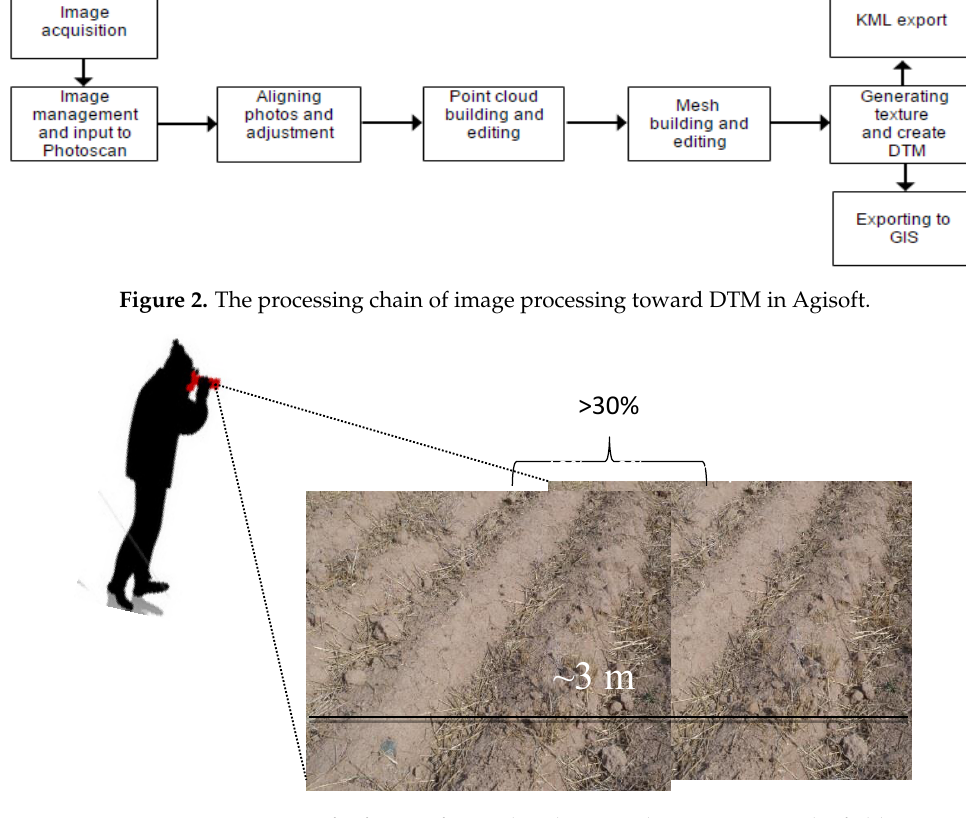
Figure 3. Acquisition of reference frames by photography capturing in the field.